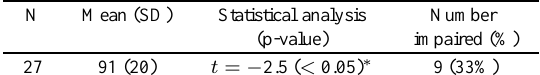
Table 5 Spearman’s rho correlations (one-tailed) between WAIS-III index